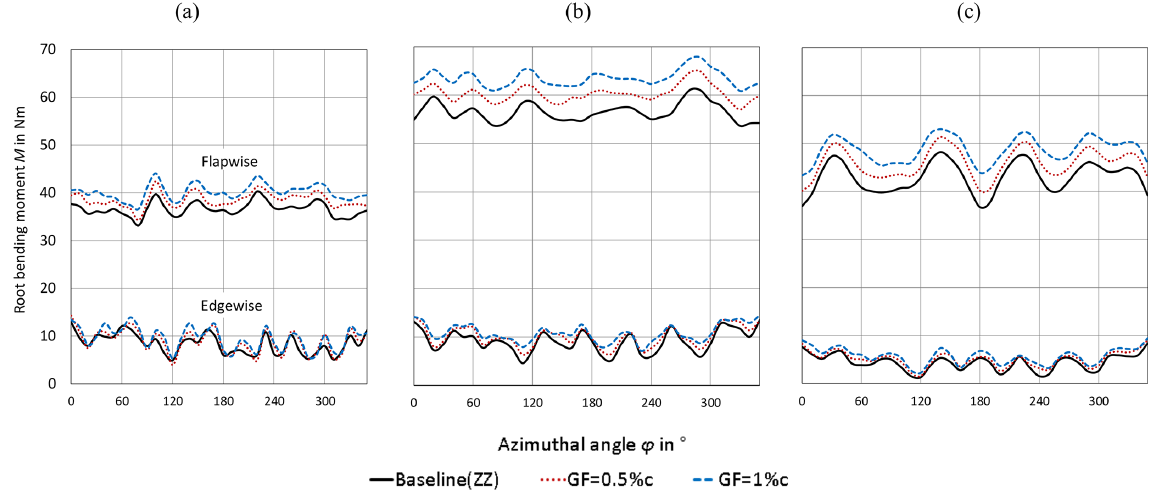
Figure 13. Flapwise and edgewise root bending moments in the tripped case. (a) TSR = 3.0. (b) TSR = 4.3. (c) TSR = 5.6.